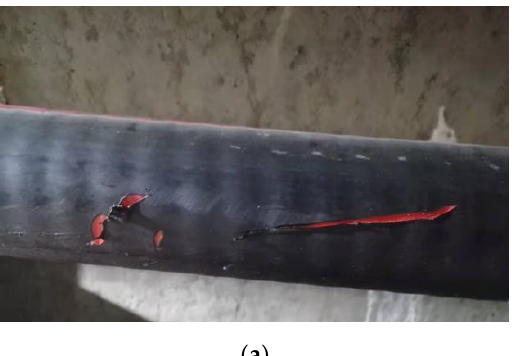
Figure 9. Test Data: ( a ) The twenty 20 sets of harmonic data statistics for line 1; ( b ) The twenty sets of harmonic data statistics for line 2.